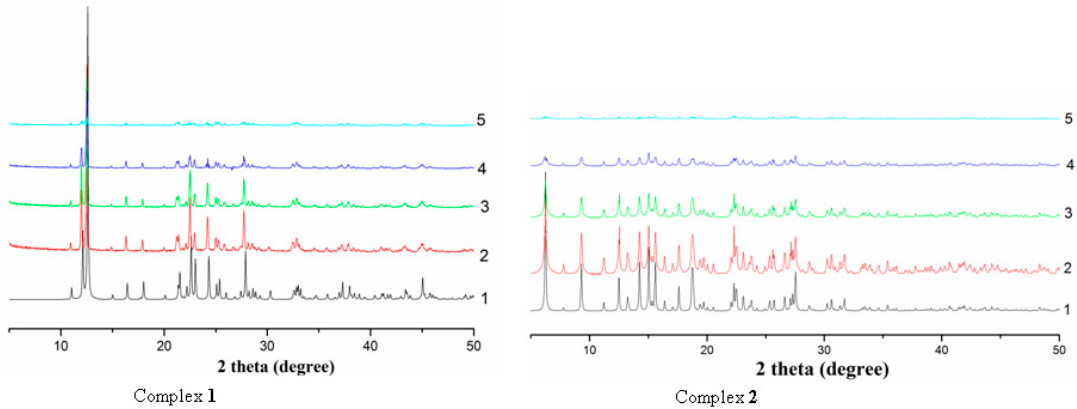
Figure 10. Powder X-ray diffraction patterns of complexes 1 and 2 at varied temperature. Complex 1 :